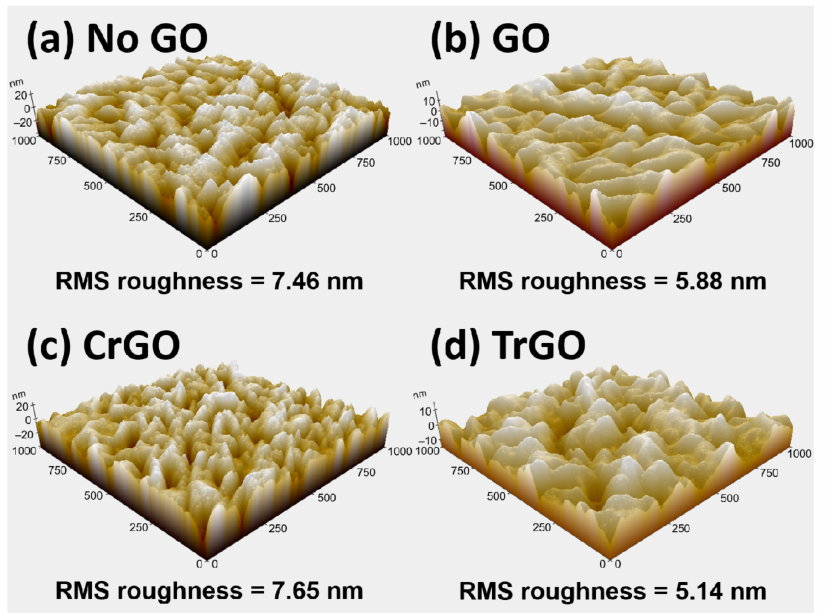
Figure 2. Atomic force microscopy (AFM) images and root-mean-square (RMS) roughness of the Mo back contacts with different intermediate layer: ( a ) no graphene oxide (GO), ( b ) GO, ( c ) chemically reduced GO (CrGO), and ( d ) thermally reduced GO